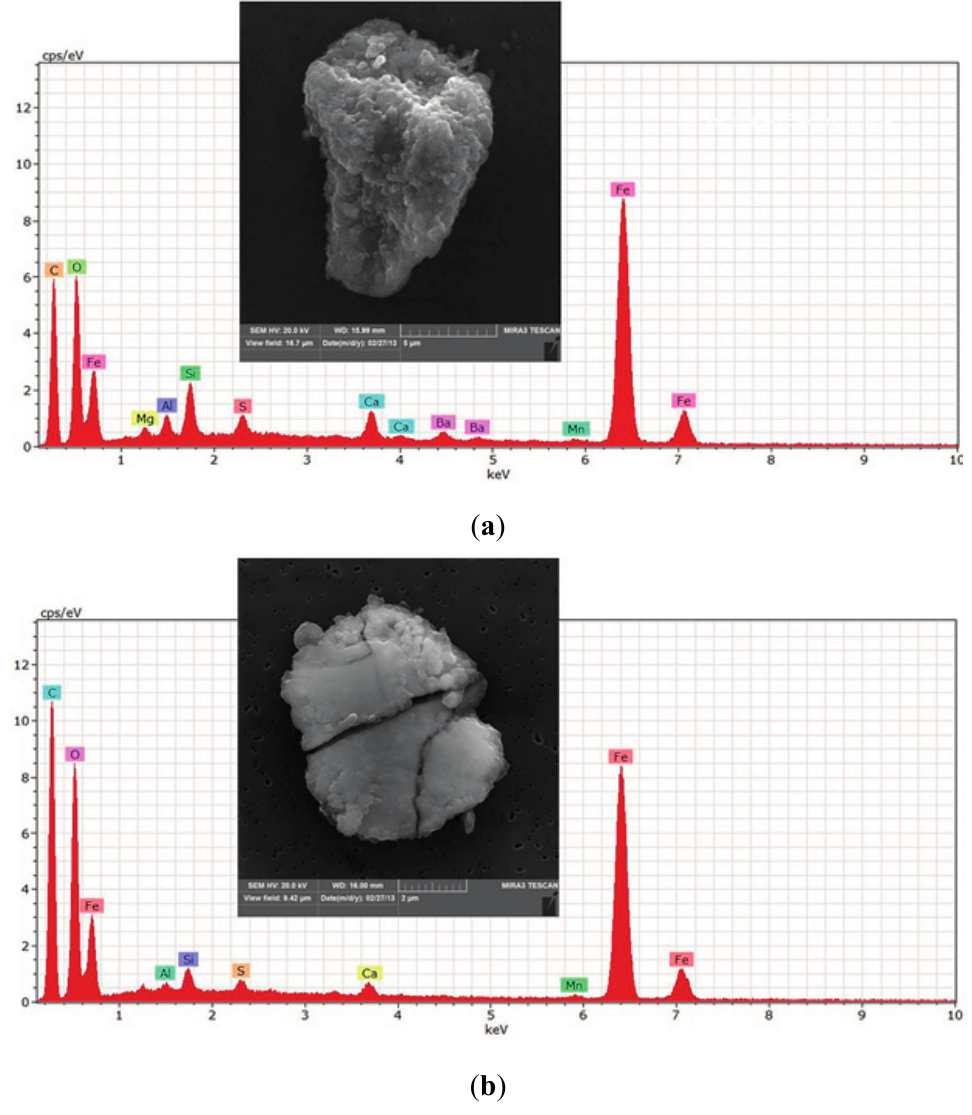
Figure 3. ( a ) Fe-Ca-Si particles from the Jegi subway station. ( b ) Fe-Ca-Si particles were